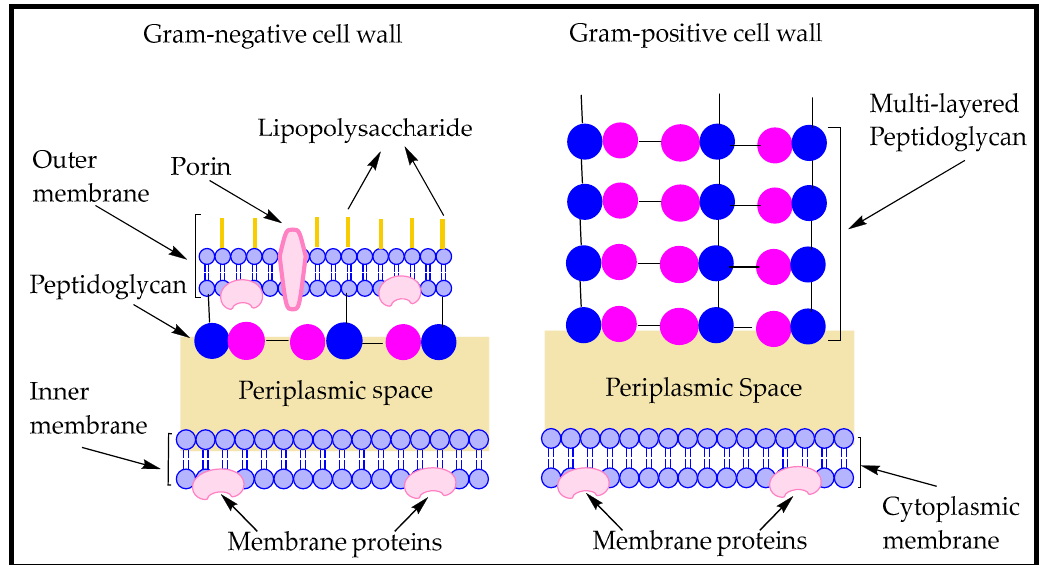
Figure 9. Gram-negative and Gram-positive bacterial cell walls, showing the location of peptidoglycan (PG) alongside other components in the respective cell walls. Basic concept (with some changes) has been drawn from Mart Ã -nez-Carmona, Gun’ko and Vallet-Reg Ã , 2018 [115]. Figure 9 has been drawn using ChemDraw software.